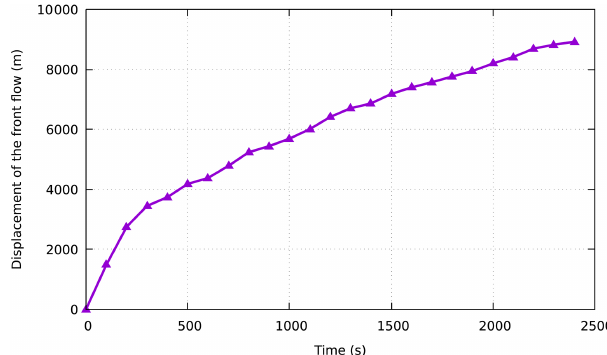
Figure 10. Displacement time history for the front of Feijão failure event in the simulation.